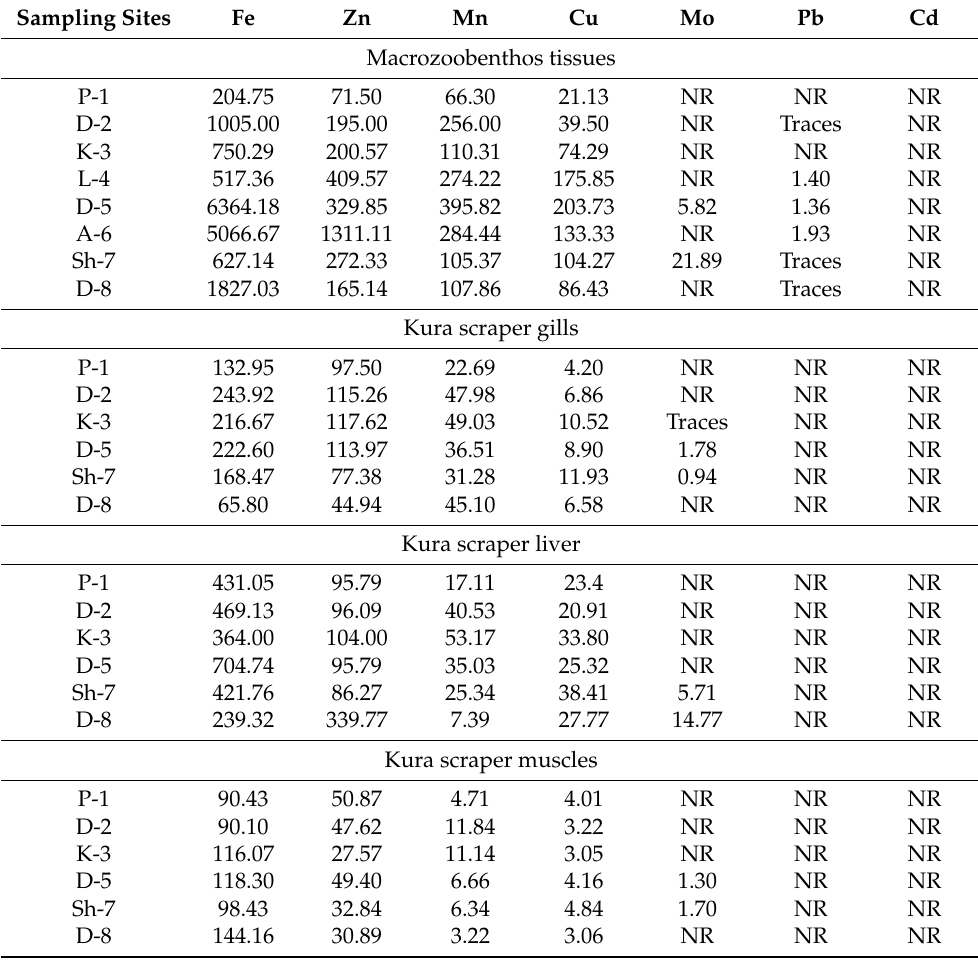
Table 5. Spatial distribution of HM concentrations (mg kg − 1 ) in the river macrozoobenthos and fish of the Debed catchment